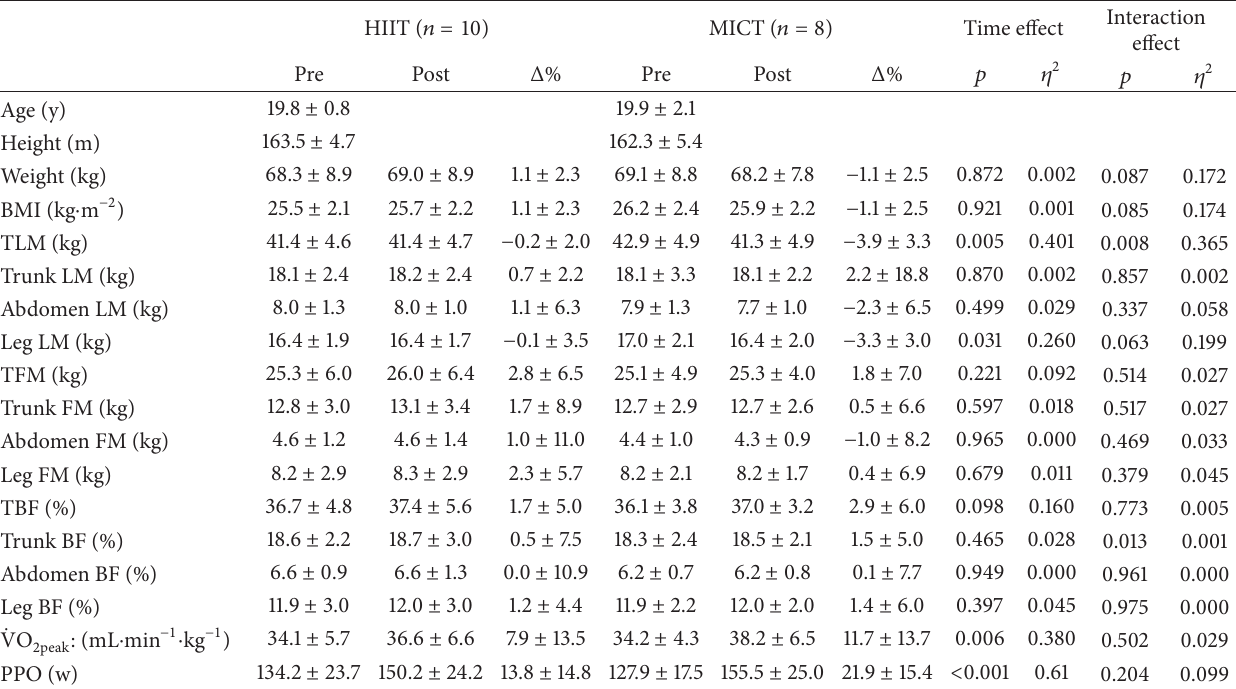
Table 1: Outcome measures before and after five weeks of exercise training.